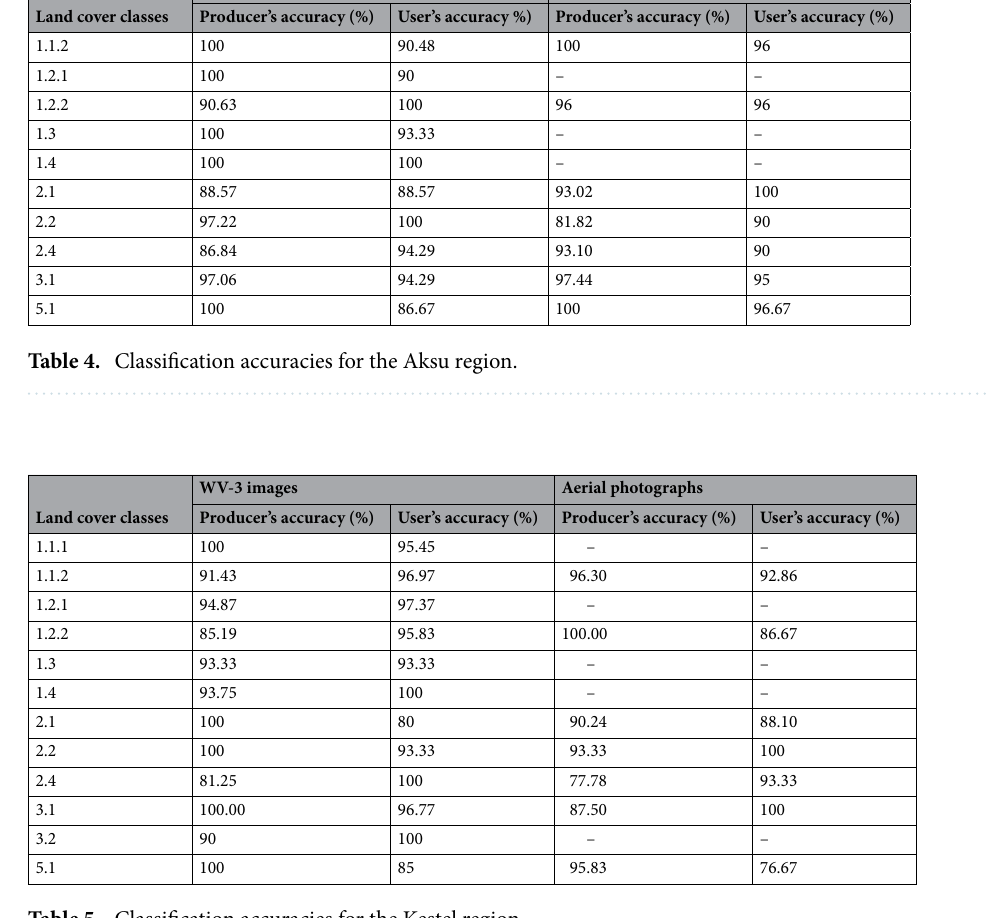
Table 5. Classification accuracies for the Kestel